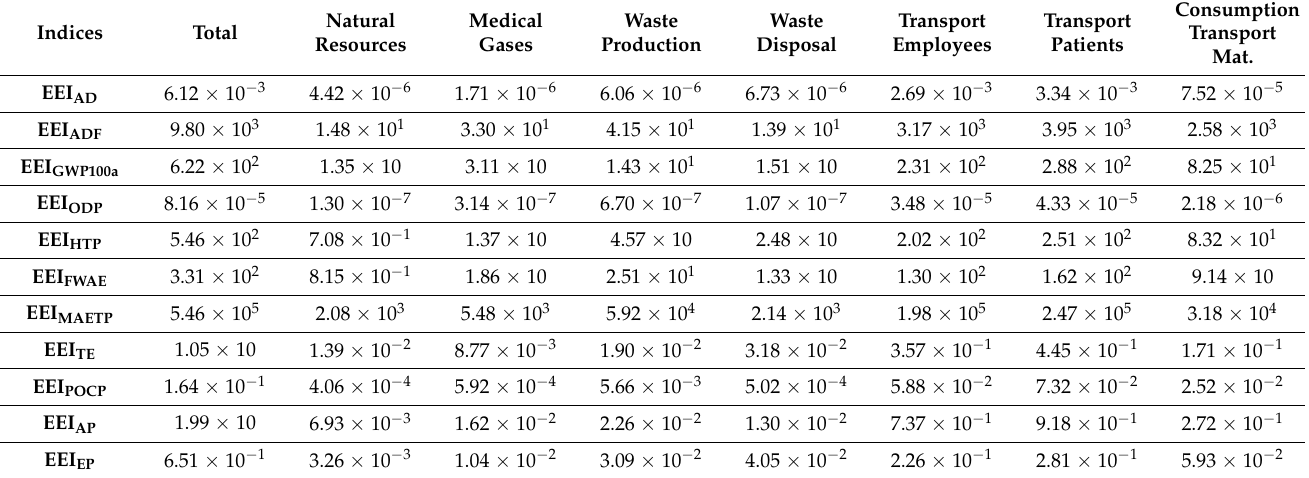
Table 4. Global environmental efficiency indices classified by impact